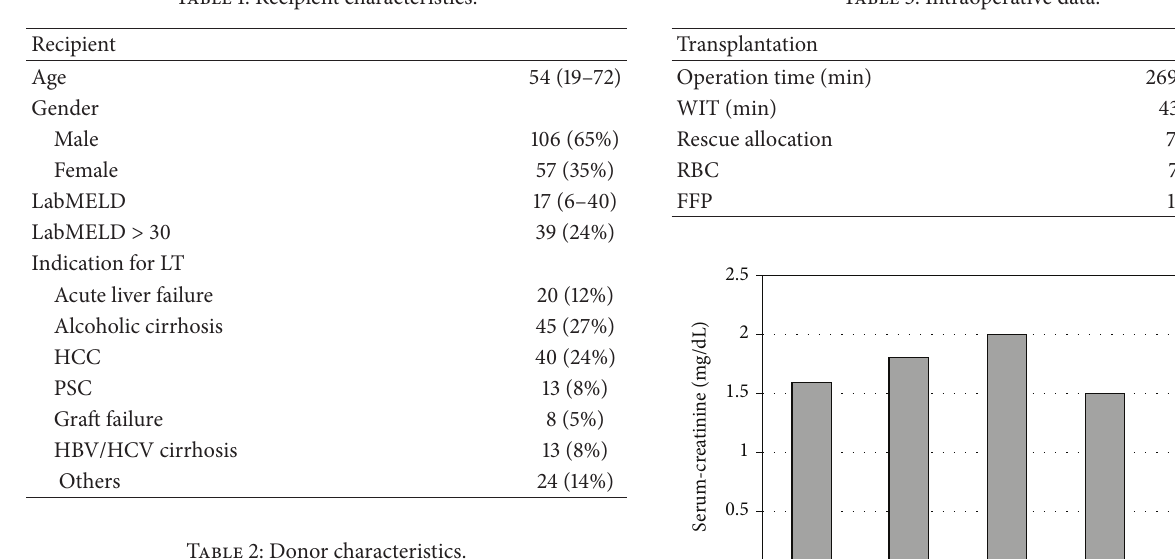
Table 3: Intraoperative data.